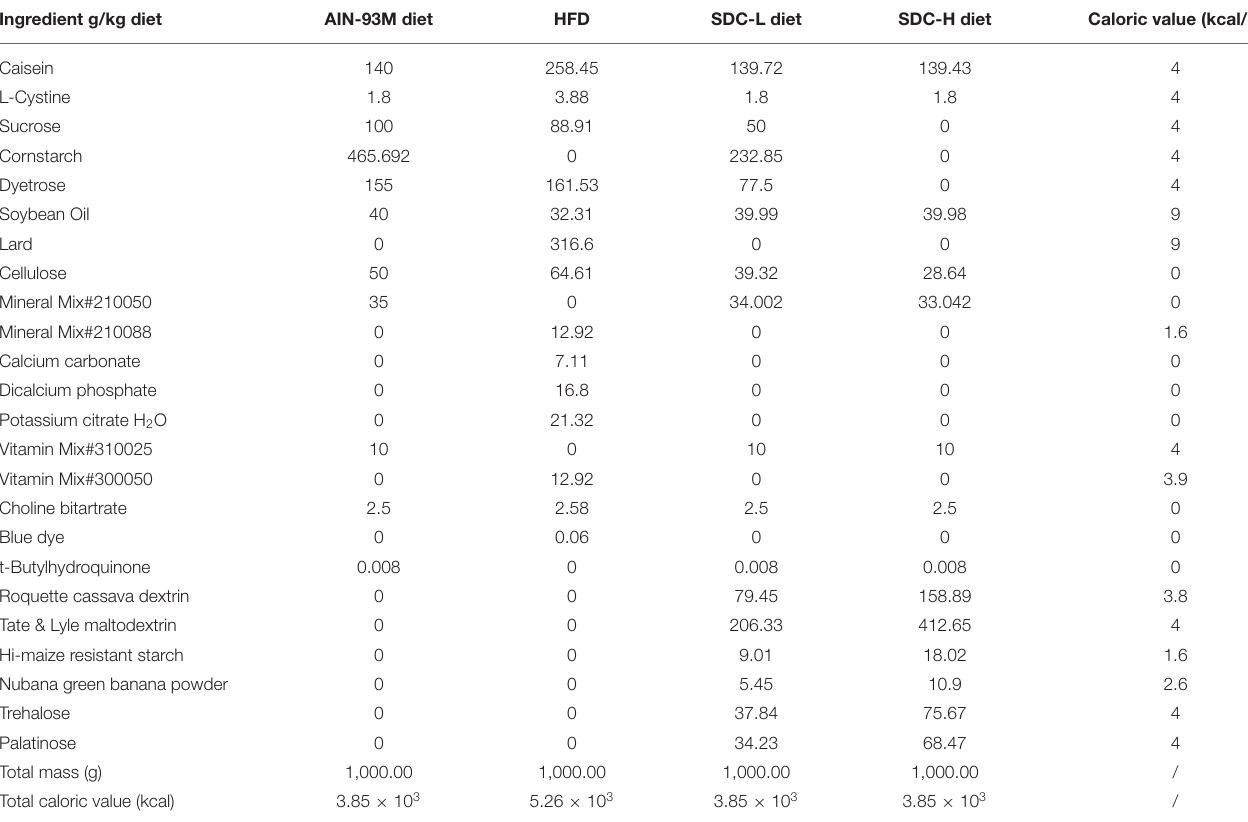
TABLE 1 | Ingredients and chemical composition of experimental diets. Ingredient g/kg